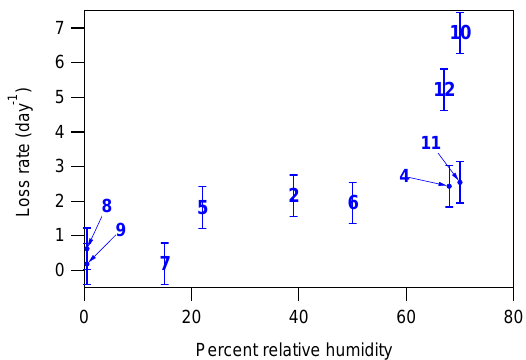
Figure 2. Time series of selected organic nitrates identified by HR- ToF-CIMS (Exp. 10).